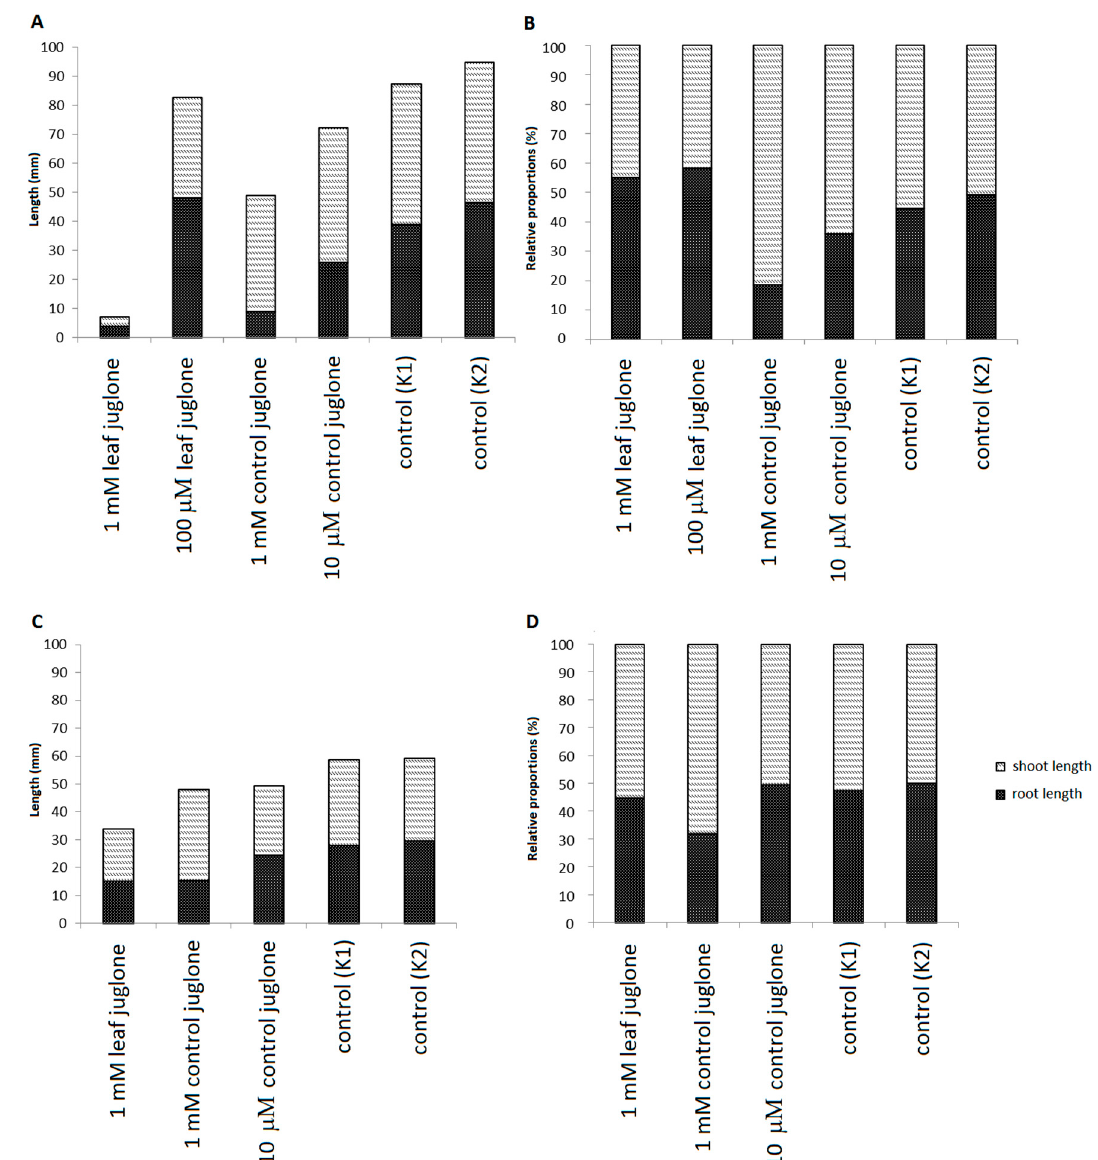
Figure 3. Effects of control juglone and known leaf extract juglone treatments on root and shoot lengths for the seedlings of S. lycopersicum ( A , B ) and L. culinaris ( C , D ) on the last day of the measurements. Both the absolute ( A , C ) and relative ( B , D ) root and shoot lengths of the seedlings are shown. K1, extraction medium (vehicle); K2, water.